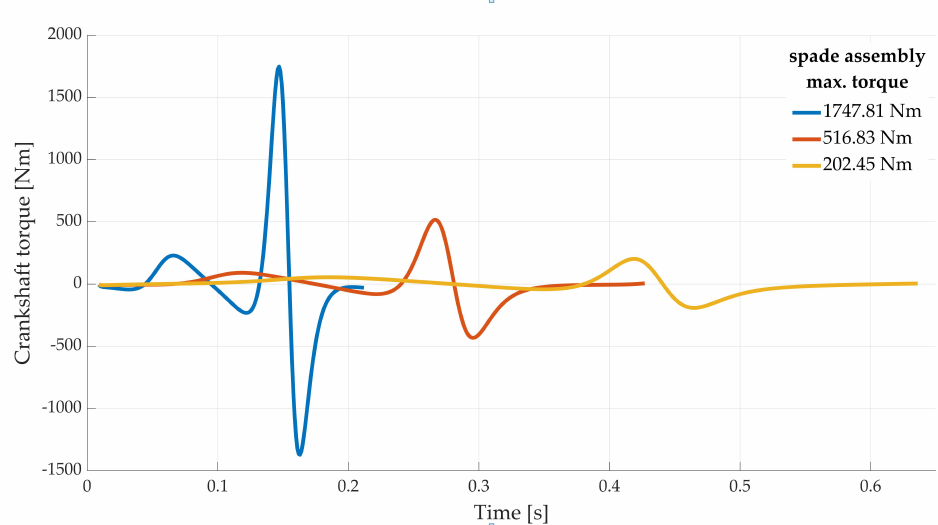
Figure 7. The spade assembly torques considering one cycle of cases IV, V, and VI, with working depth of 0